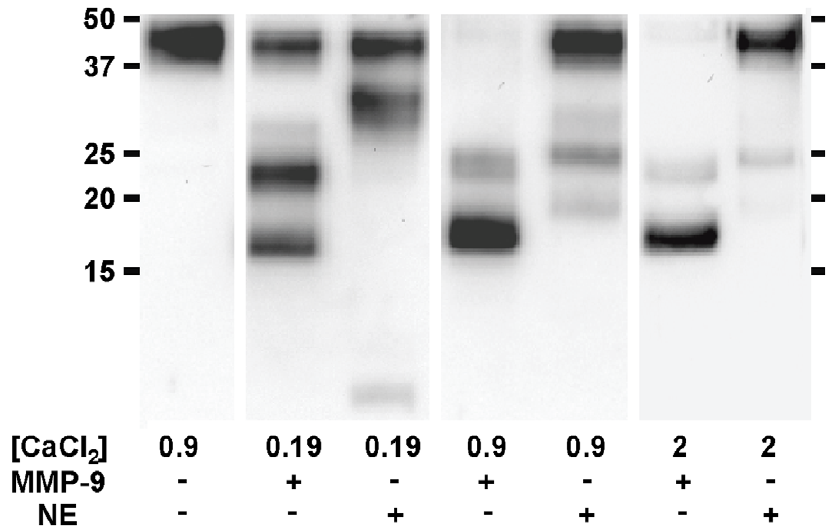
Figure 5. MMP-9 cleaves SP-D more potently than NE at higher calcium concentrations. Comparison of the fragments produced by cleavage with SP-D and NE. CaCl 2 concentrations are listed in mM. For experiments at 0.19 mM CaCl 2 , incubations were carried out for 10 min at protease concentrations of 16.95 nM. For experiments at 0.9 and 2 mM CaCl 2 , incubations were carried out for 4 hours with or without protease at 60.24